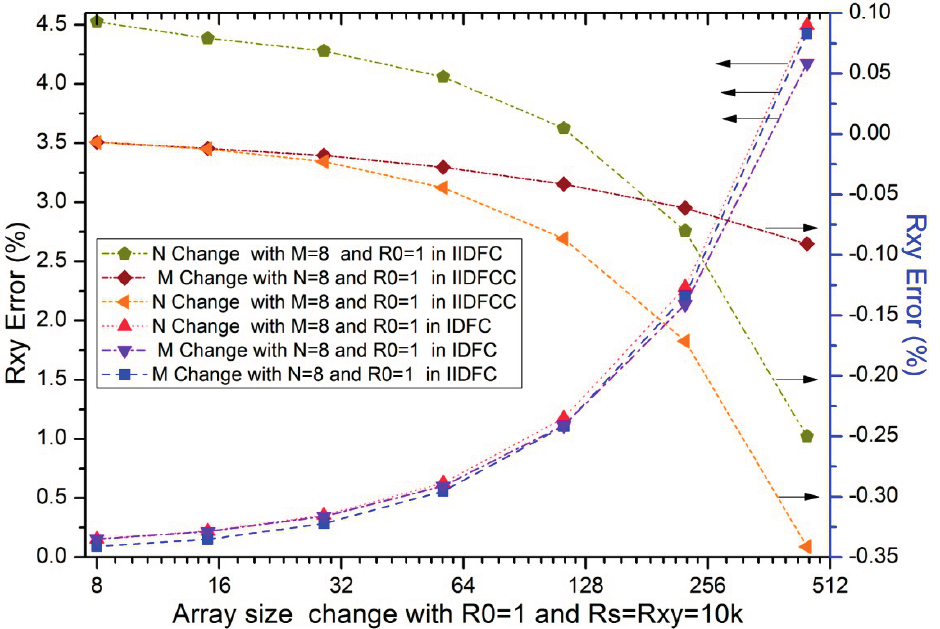
Figure 4. The array size effect on the R R = 10 k Ω . xy